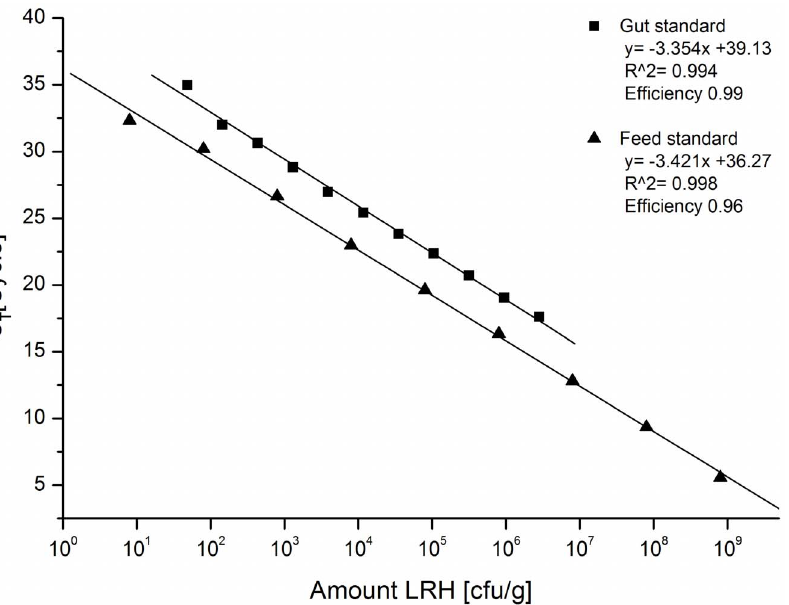
Figure 1. qPCR standard curve for quantification of L.reuteri (LR) in feed and gut samples. The standard curves were generated by amplification of serially diluted DNA from feed spiked with 8.0 6 10 8 cfu/g and from gut lumen content spiked with 8.5 6 10 6 cfu/g.